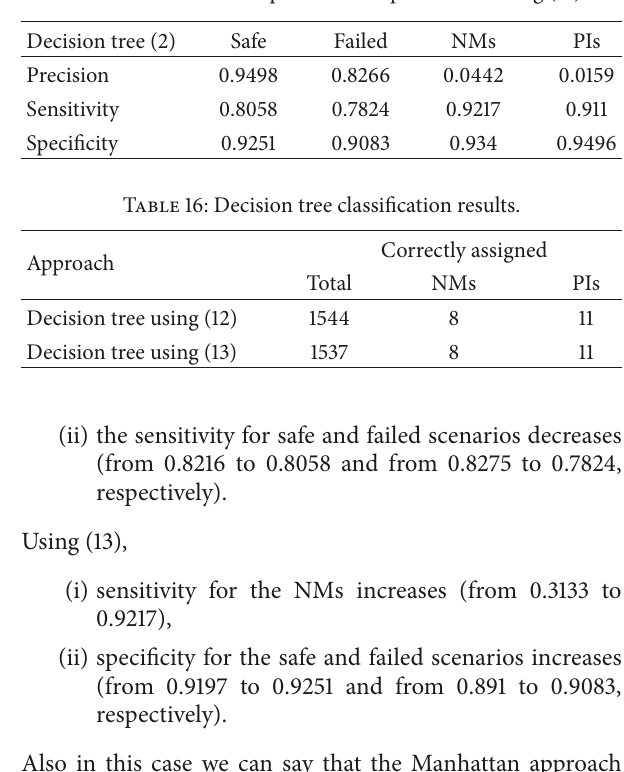
Table 15: Decision tree performance parameters using (13).